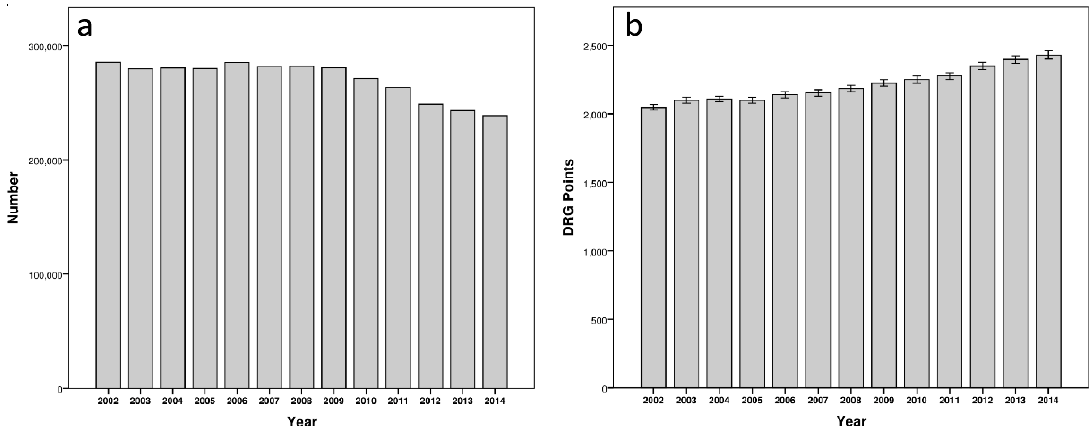
Figure 1. ( a ) The annual number of hospitalizations showed a decreasing trend in the period considered; ( b ) on the contrary the costs expressed in DRG points per admission increased over time.